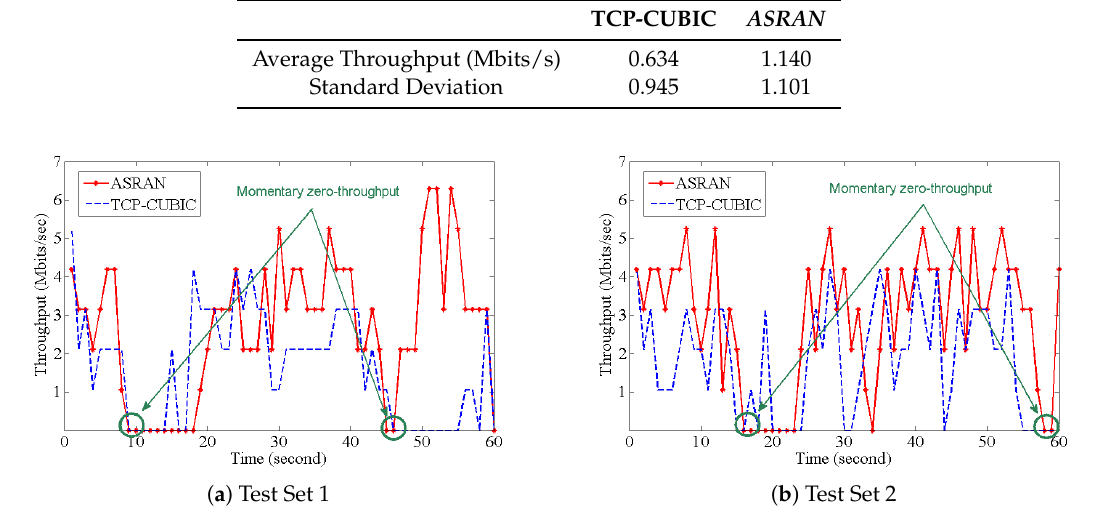
Table 1. Comparison of experiment when transient link instability appears.